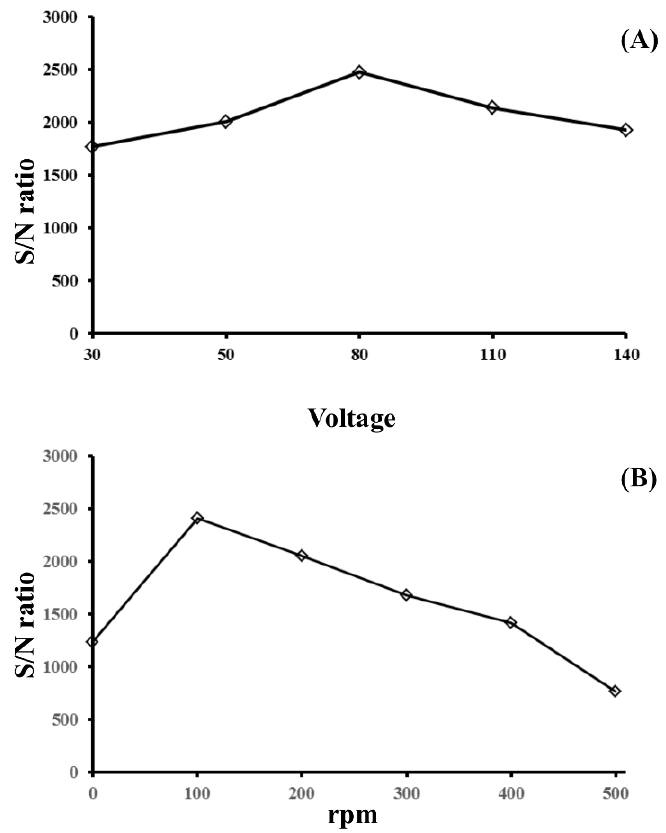
Figure 3. Effect of ( A ) the applied voltage and ( B ) the stirring rate on the S/N ratio of posaconazole obtained from EME. Experimental conditions: sample volume, 8 mL; extraction time, 5 min; and posaconazole concentration, 0.50 μM. All other conditions were identical to those outlined in Figure 2.